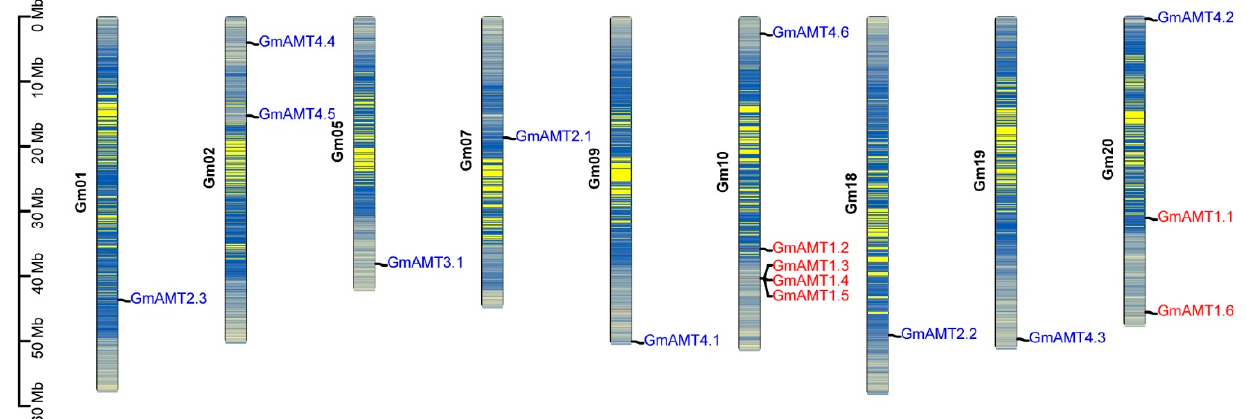
Figure 2. Chromosomal distribution analysis of GmAMT genes. The genome visualization tool of TBtools was used to map the chromosomal distribution of GmAMT genes. The colors of the bars indicate soybean chromosomes, and the color gradients in chromosomes represent gene density. Gene names were marked on each chromosome. GmAMT1 and GmAMT2 subfamily genes are highlighted with red and blue colors, respectively. The scale bar is presented on the left side.